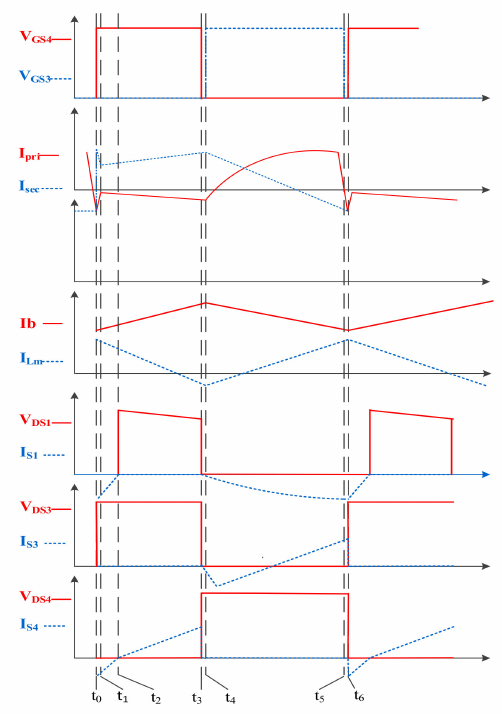
Figure 8. Key waveforms in Stage